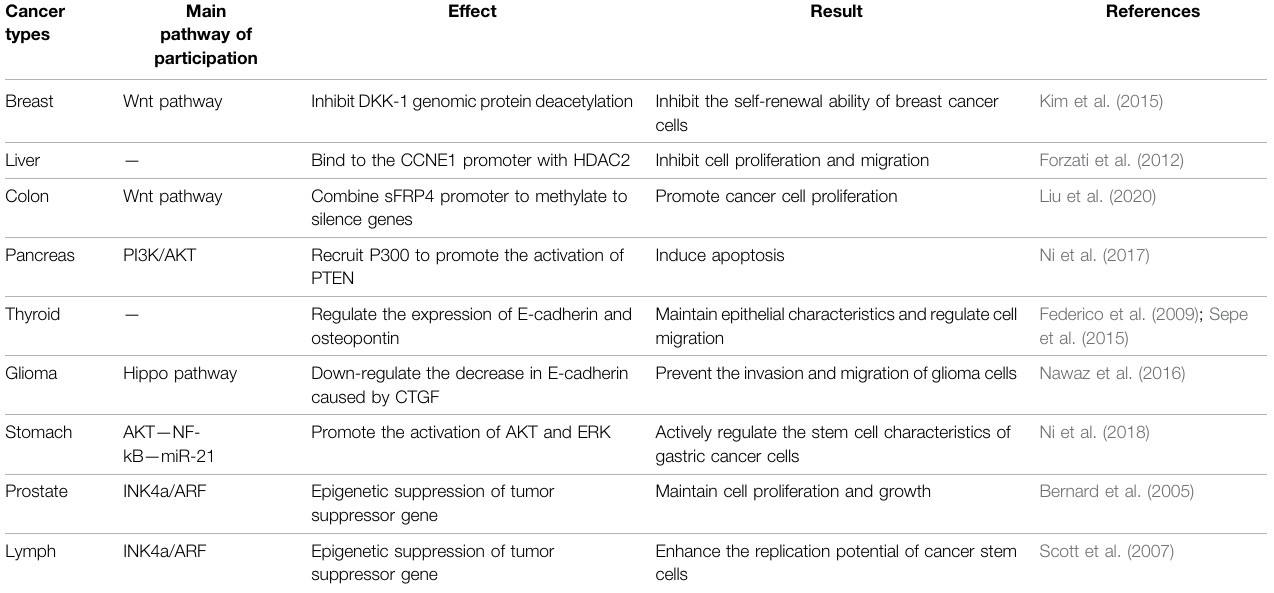
TABLE 1 | CBX7 participates in various pathways and plays different physiological effects in different